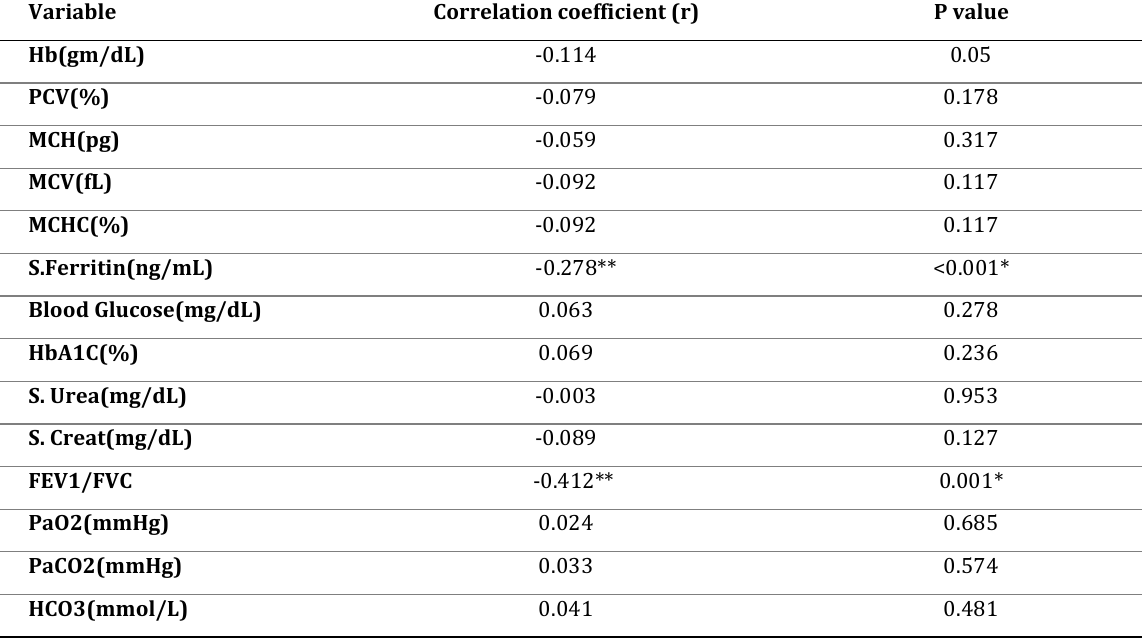
Table 7: Correlation of RLS with laboratory studies, spirometry and arterial blood gas readings of COPD